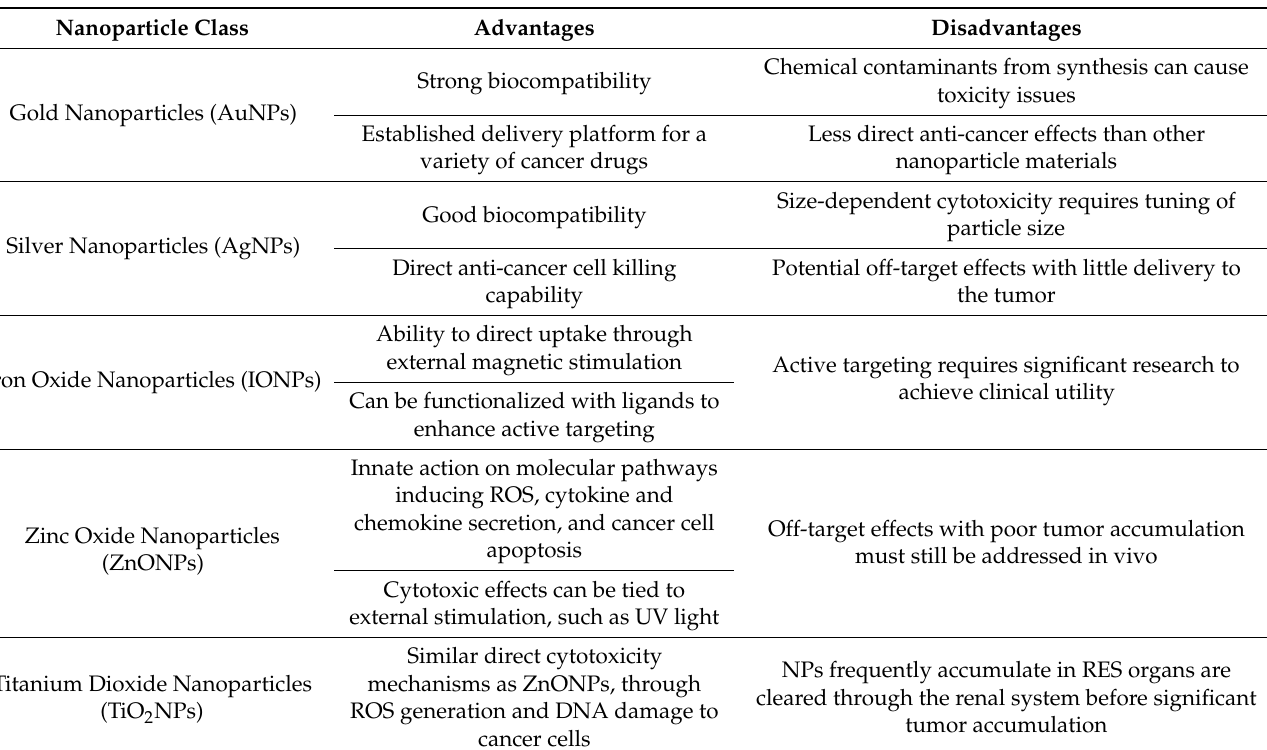
Table 2. Advantages and Disadvantages of Metallic and Metal Oxide Nanomaterials for Cancer